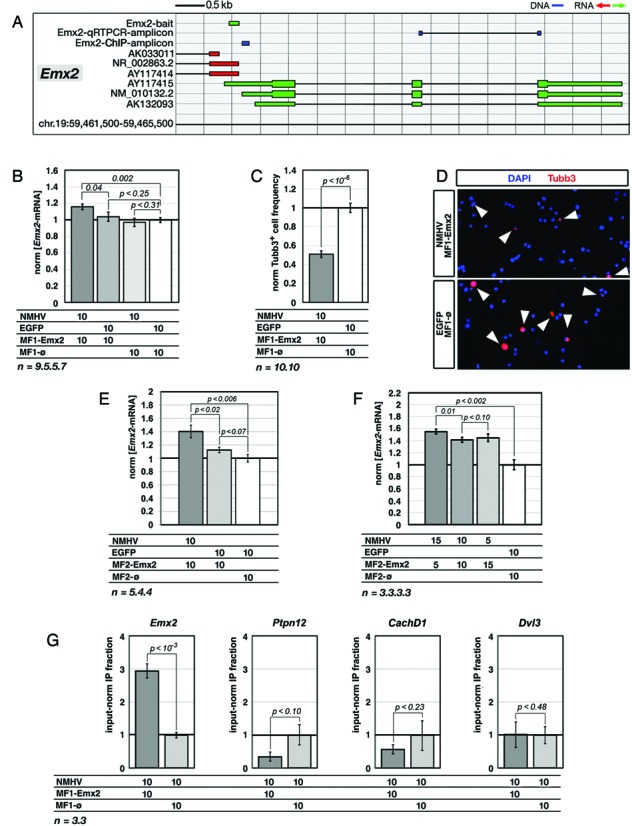
NMHV-mediated transactivation of Emx2 in murine, embryonic cortico-cerebral precursors and its molecular and biological correlates. (A) Schematics of the murine Emx2 locus, with natural transcripts, artificial baits and diagnostic amplicons used in this study. Nucleotide numbering refers to UCSC-mm10. Color code: blu, DNA; green, sense-oriented RNA; red, antisense-oriented RNA. (B)Emx2-mRNA upregulation in precursors infected by NMHV- and MF1-Emx2-encoding lentivectors. EGFP and MF1-øviruses were used as controls. Results were normalized against Gapdh and further normalized against the EGFP/MF1-øcombination. (C) Reduced frequency of cells immunopositive for the neuron-specific Tubb3 marker, in cultures of NMHV/MF1-Emx2-overexpressing precursors. Results were normalized against EGFP/MF1-øcontrols. (D) Examples of aTubb3 immunofluorescences referred to in (C). (E) Enhancing Emx2 transactivation by improving the RNA cofactor structure. The assay was run similar to Figure 2A, replacing the monomeric-finger ‘MF1-bait’ cofactor by its dimeric-finger ‘MF2-bait’ derivative. (F) Enhancing Emx2 transactivation by increasing the m.o.i. ratio of NMHV- and MF2-Emx2-encoding lentiviruses. The best results were obtained by an NMHV/MF2-Emx2 ratio of 3:1. (G)Emx2 promoter enrichment in chromatin of NMHV/MF1-Emx2-overexpressing precursors, immunoprecipitated by an anti-HA antibody. Results were normalized against input chromatin and further normalized against the NMHV/MF1-øcontrol. Promoters of potential Emx2-offtargets Ptpn12, CachD1 and Dvl3 were used as specificity controls. In all cases (B-G), cortico-cerebral cells were dissociated from E12.5 embryos, acutely infected, cultured for 96 h and finally analyzed. Throughout the figure, lentiviral multiplicities of infection (moi's) and numbers of biological replicates, n, are displayed under the graphs. Bars represent s.e.m.'s.